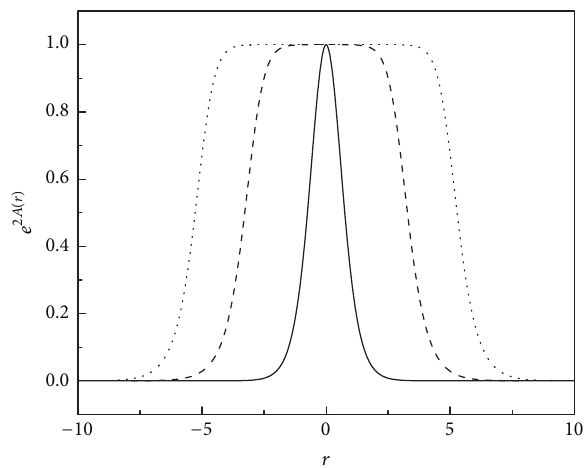
Figure 1: Plots of warp factor 𝑒 2퐴(푟) for 𝑎 = 0 (solid line), 𝑎 = 3.0 (dashed line), and 𝑎 = 5.0 (dotted line) and we put 𝜆 = 1.0